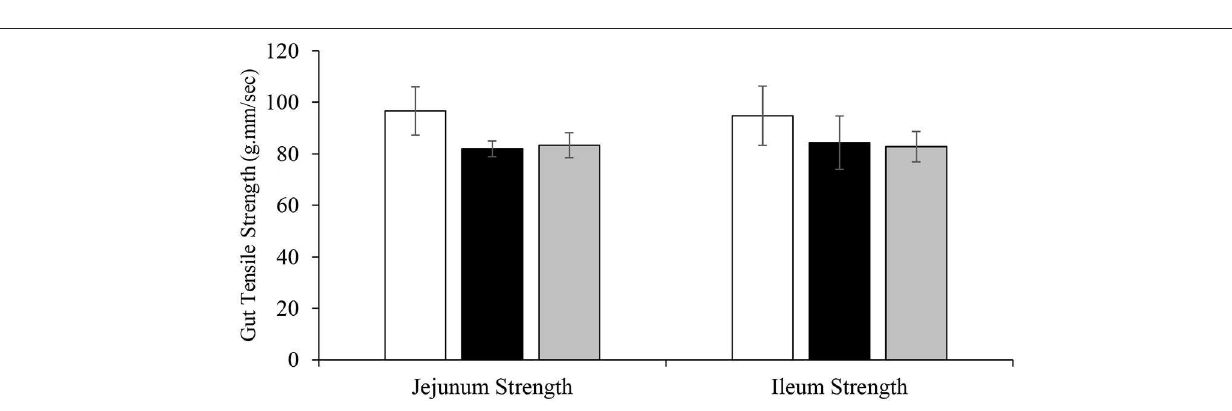
FIGURE 4 | Lesion scores of duodenum, jejunum, and cecum on d 21. a – c Bars with different superscripts are significantly different ( P < 0.05).